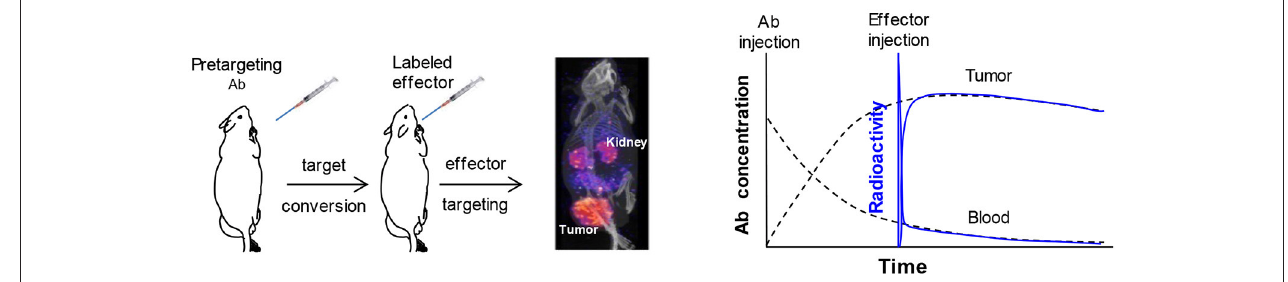
FIGURE 1 | A typical pretargeting procedure and a schematic demonstration of the antibody concentration (in %ID/g) and the effector radioactivity (also in %ID/g) in the tumor and blood. Injection of the pretargeting antibody converts the antigen into a secondary target that binds the effector and injection of the effector allows the label to accumulate into tumor as illustrated in the pinhole SPECT image. In the schematic demonstration, the scales of antibody concentration and the effector radioactivity are adjusted to allow the curves for superimposition after the circulating free effector is cleared. It shows the concept of the in vivo labeling of the antibody and enables a better appreciation that the ratio of the tumor/blood area-under-curve for the effector radioactivity is much larger than that of the antibody.